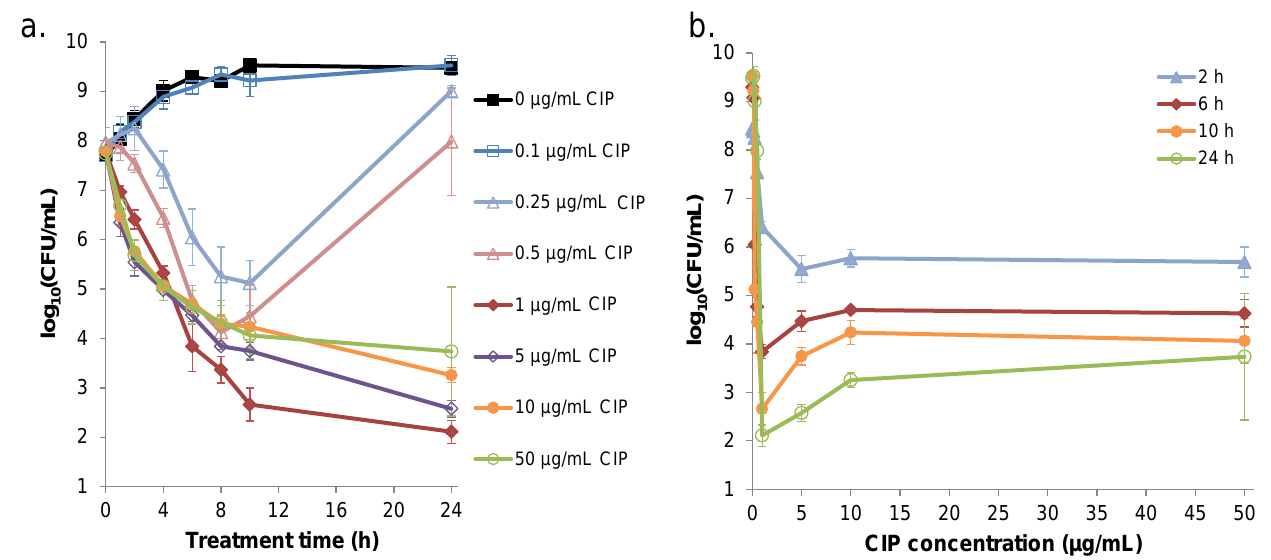
Figure 1. Ciprofloxacin (CIP) treatment of S. aureus cultures. S. aureus NCTC 8325 was grown in LB for 4 h prior to treatment with 0–50 µg/mL ciprofloxacin. At designated time points, samples were washed to remove ciprofloxacin, serially diluted, plated on LB agar, and incubated overnight to enumerate colony-forming units (CFUs). Survival data are plotted versus ( a ) treatment time and ( b ) CIP concentration. Data points are the mean of the log 10 (CFU/mL) across three to four replicate experiments and error bars indicate standard error of the mean (SEM), except for the 24 h time point of 50 µg/mL CIP, which was only replicated